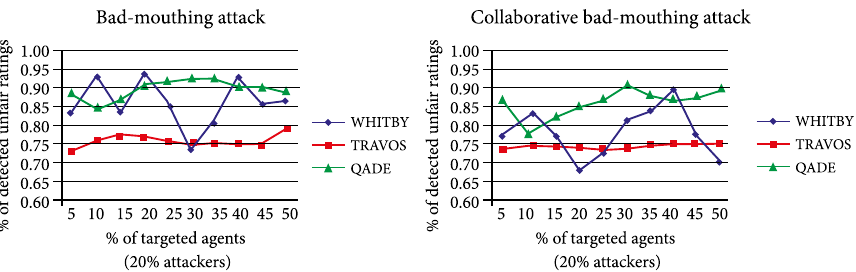
Fig. 6. The percentage of detected unfair ratings in the “Bad-mouthing attack” configurations with different number of targeted